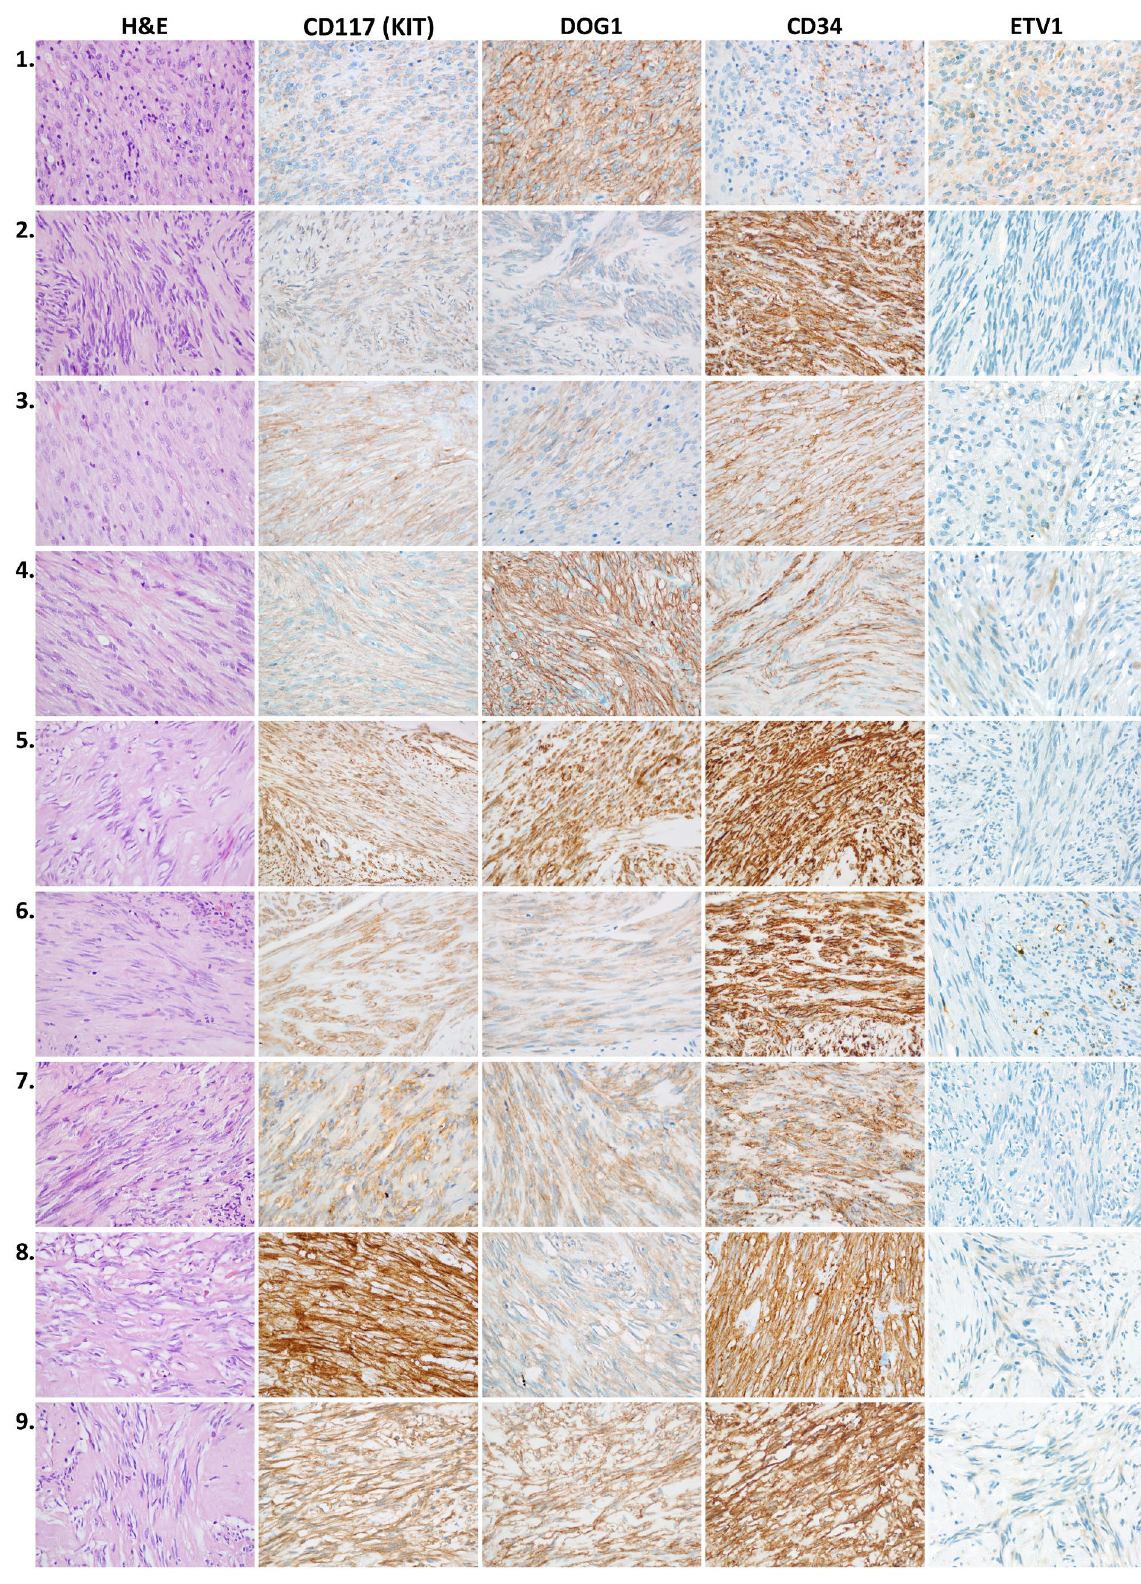
Figure 2. Immunohistochemical analysis of micro-GIST samples of the nine cases. H&E hematoxylin and eosin, CD cluster of differentiation, DOG1 discovered on GIST-1. Original magnification: 600